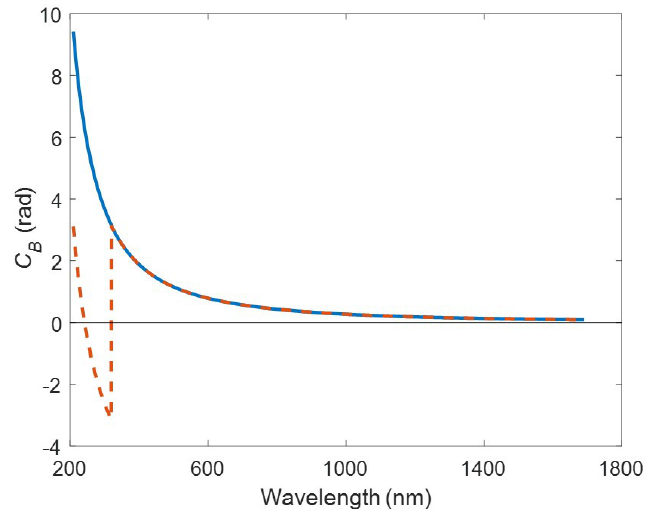
Figure 5. The birefringence C B (solid curve) for an α -quartz sample determined by differential decomposition of the MMSE data in Figure 4. The dashed curve shows unfolded C B as obtained from the differential